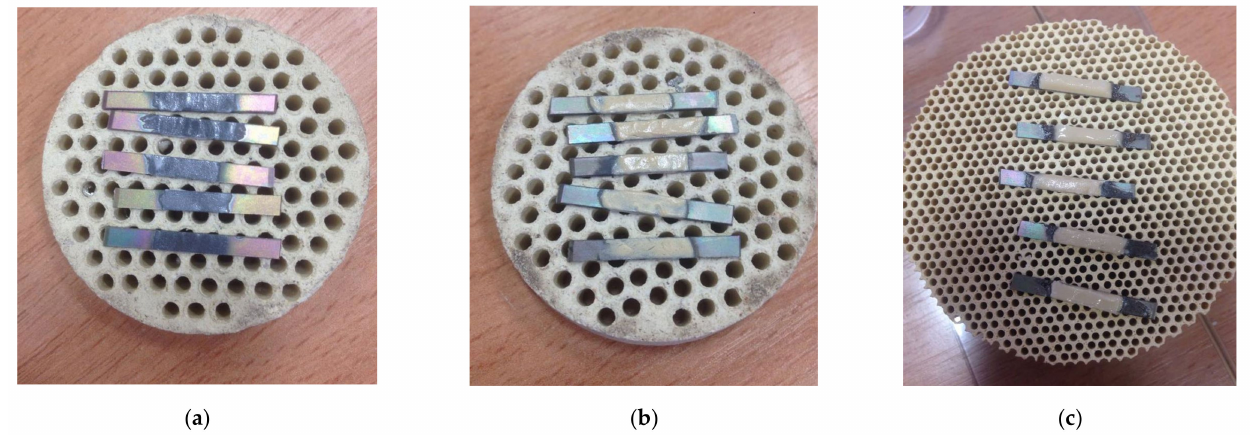
Figure 1. Titanium 99.2—Duceratin Kiss porcelain samples after firing process, ( a ) Bond, ( b ) Opaque, ( c ) Dentin.